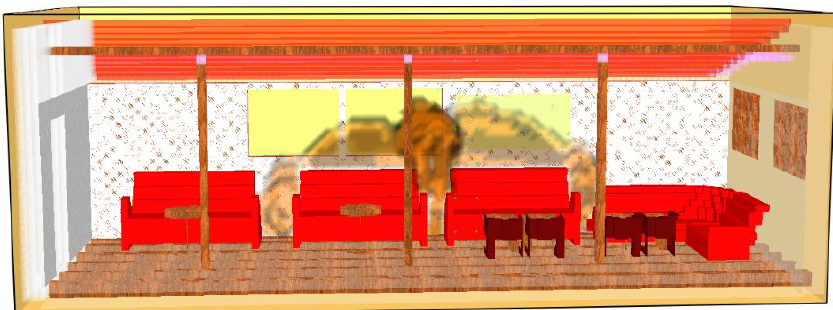
Figure 7. Fire developing on the inside of the eastern wall.